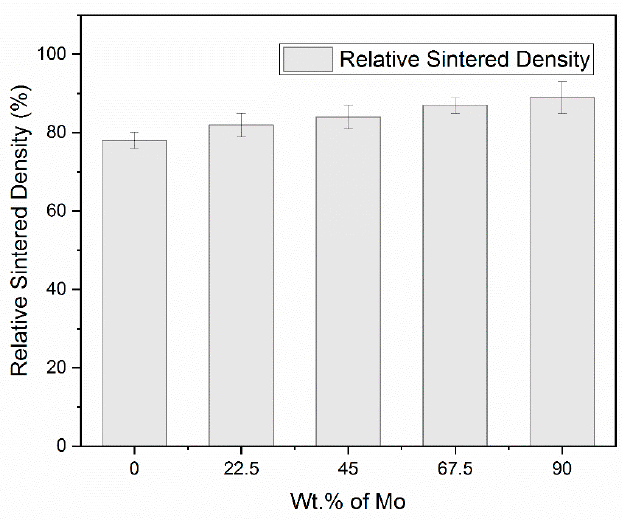
Figure 2. Graphical representation of variation in sintered density with the increase in molybde- num